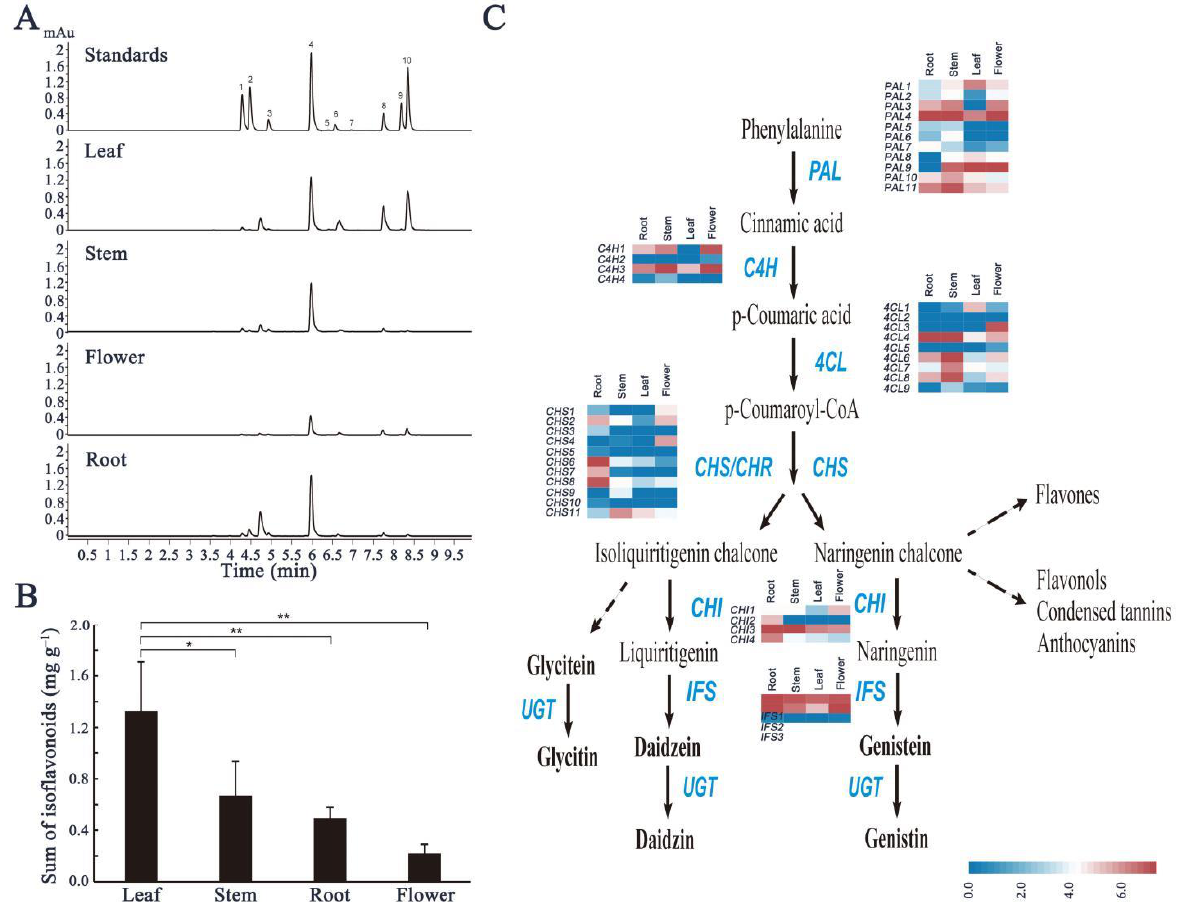
Figure 4. Content of selected isoflavonoids in different tissues of red clover and analysis of the differential expression of isoflavonoid synthesis structural genes. ( A ) HPLC/MS elution profiles of isoflavonoid components extracted from different tissues. Peak numbers corresponding to isoflavonoids are shown in Table S1. ( B ) Total isoflavonoid content (mg/g dry weight) in different tissues. Bar data are the means of three biological replicates ± SD, and ANOVA analyses were conducted using a one-way analysis of variance and Student’s t -test. Asterisks indicate a significant difference (* p < 0.05, ** p < 0.01). ( C ) Pathway of isoflavonoids biosynthesis in plants and the expression patterns of differentially expressed structural genes in four tissues, shown in heatmaps. PAL : phenylalanine ammonia-lyase; C4H : cinnamate-4-hydroxylase; 4CL : 4-coumarate-CoA ligase; CHS : chalcone synthase; CHR : chalcone reductase; CHI1 : chalcone isomerase; IFS : 2-hydroxyisoflavanone synthase; UGT : uridine diphosphate glycosyltransferase.